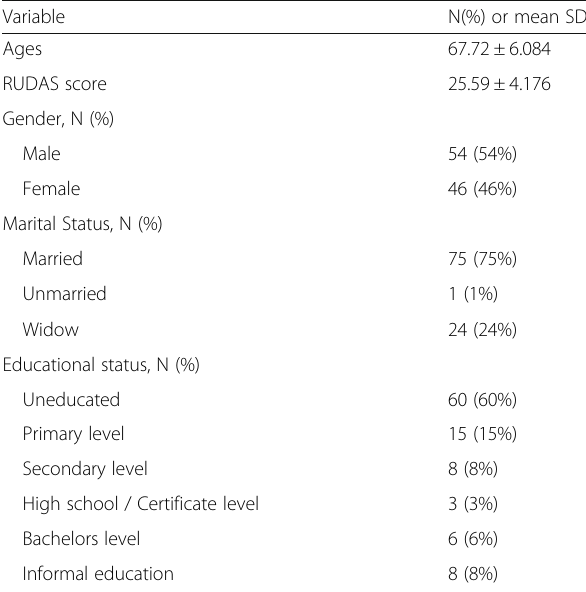
Table 4 Demographic details and RUDAS scoring in computing internal